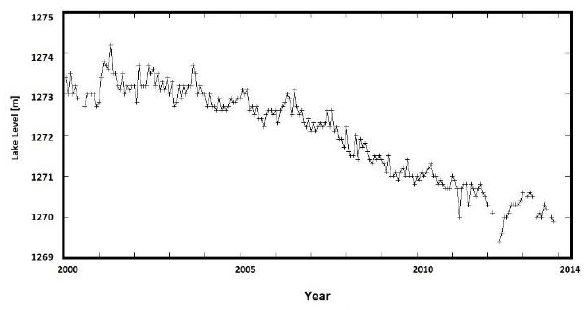
As shown in Figure 3, there is a time series of surface water extent extracted from MODIS imagery during 2000-2014. Within the period of 2000 to 2014 the downward trend of the water level has shown to confirm extreme droughts in Region.